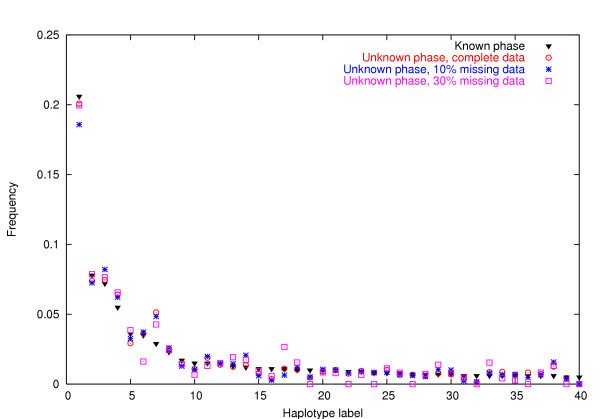
Point estimates for multiallelic data. Point estimate haplotype frequencies for multiallelic data set for phase-known and phase-unknown data with 0%, 10%, and 30% missing data.